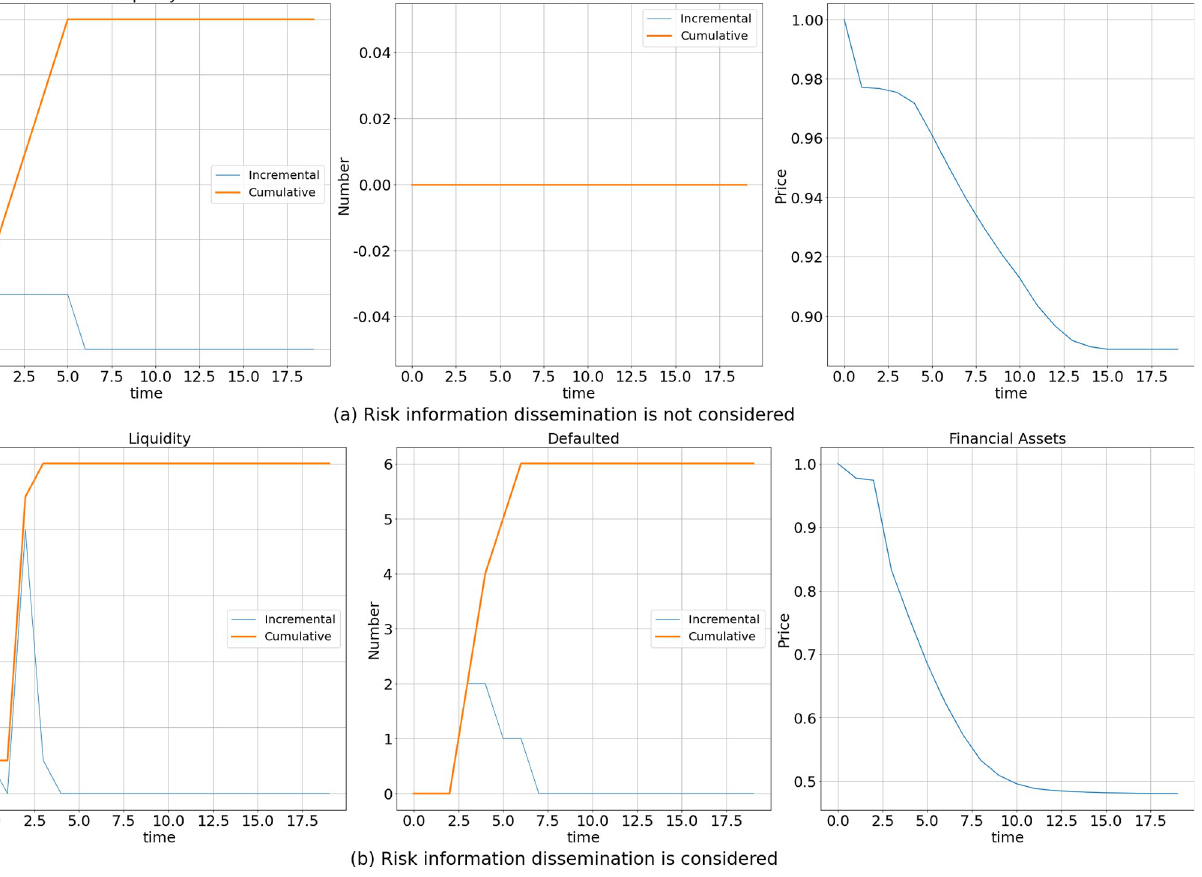
PLOS ONE | https://doi.org/10.1371/journal.pone.0270482 July 25,